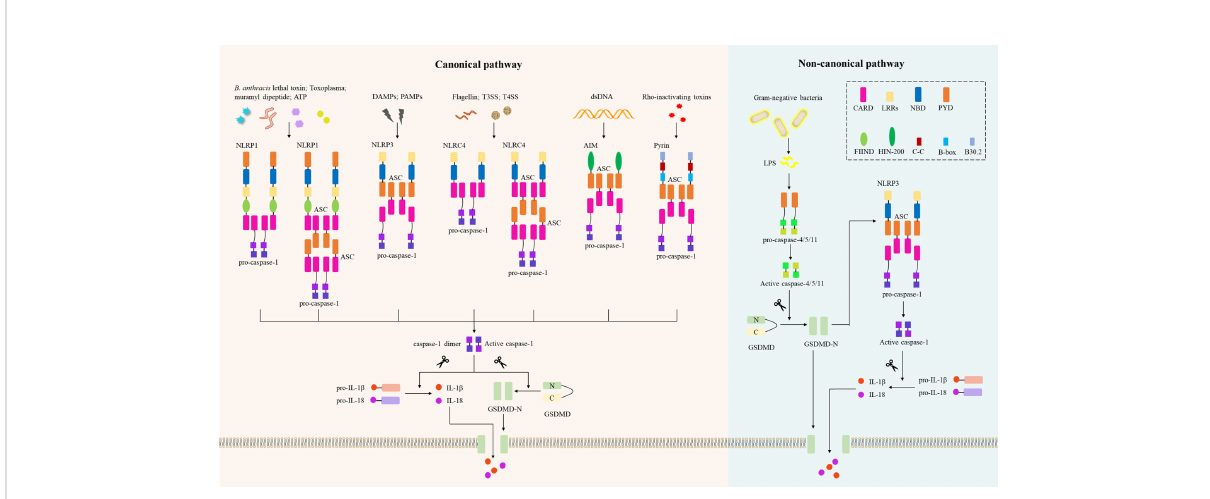
FIGURE 2 In fl ammasomes in the canonical and non-canonical pyroptotic pathway. In the canonical pathway, danger-associated molecular patterns (DAMPs) or pathogen-associated molecular patterns (PAMPs) activate their respective in fl ammasome sensors, including NLRP1, NLRP3, NLRC4, AIM2, or Pyrin. B. Anthrax toxins, Toxoplasma, ATP, etc. activate the NLRP1 in fl ammasome, and NLRP1 recruits pro-caspase-1 via ASC or via CARD-CARD interaction. Multiple DAMPs and PAMPs activate the NLRP3 in fl ammasome, which subsequently recruits ASCs and pro-caspase-1. NLRC4 senses bacterial fl agellin and T3SS/T4SS components and activates caspase-1 in an ASC-dependent or ASC-independent manner. The AIM2 in fl ammasome assembles when AIM2 senses host- or pathogen-derived dsDNA; the pyrin in fl ammasome is activated by Rho-inactivating toxins, and both AIM2 and pyrin activate caspase-1 in an ASC-dependent manner. Activated caspase-1 induces proteolytic cleavage of GSDMD to generate N-GSDMD, which then forms the GSDMD-N pore and induces pyroptosis. Activated caspase-1 also induces proteolytic maturation of IL-1 b and IL-18 to their active forms, which are secreted through the GSDMD-N pore. In the non-canonical pathway, LPS from Gram- negative bacteria are recognized by caspase-4 or caspase-5 in human cells or caspase-11 in mouse cells. These activated in fl ammatory caspases directly cleave GSDMD and form GSDMD-N pores to trigger pyroptosis. The GSDMD-N-terminal fragment also activates the NLRP3 in fl ammasome and induces caspase-1-dependent maturation of IL-1 b and IL-18. CARD, caspase recruitment domain; LRRs, leucine-rich repeats; BD, nucleotide-binding and oligomerization domain; PYD, pyrin domain; N FIIND, a functional-to- fi nd domain; HIN-200, hematopoietic interferon-inducible nuclear protein 200; CC, coiled-coil; B-box, B-box-type zinc fi nger; AIM2, absent in melanoma 2; ASC, apoptosis-associated speck-like protein containing a caspase recruitment domain; GSDMD, gasdermin D; LPS,